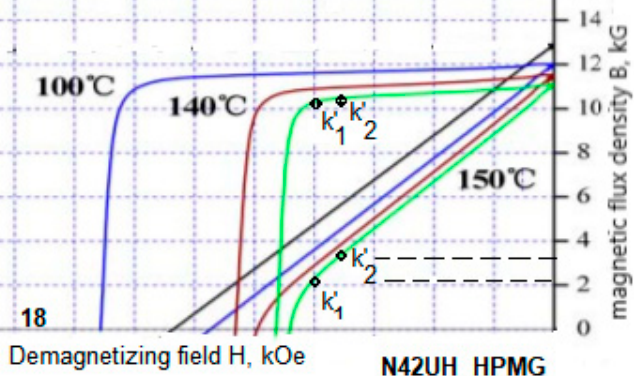
Figure 3. Manually picked knee endpoints k 1 ′ and k 2 ′ can differ by 50%.